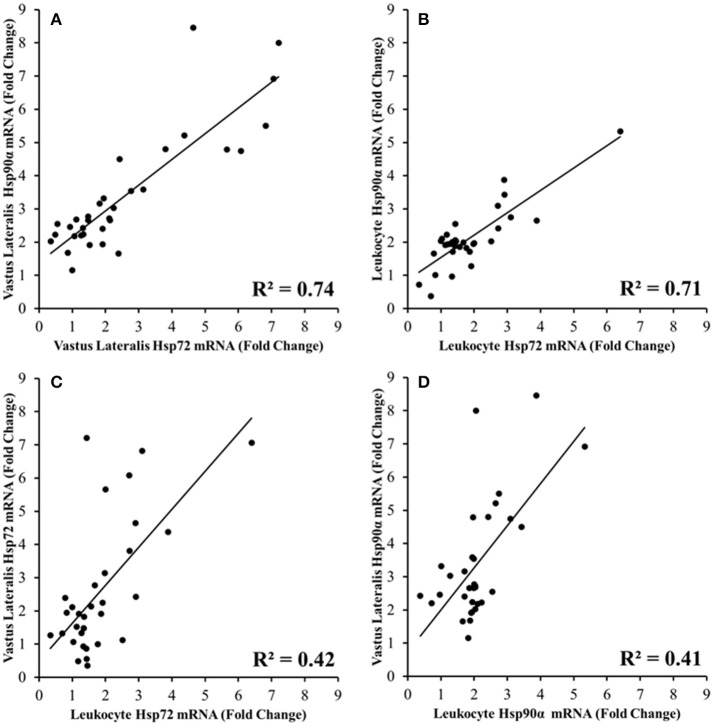
Relationships between Hsp72 (A,C) and Hsp90α mRNA (B,D) responses in the Vastus Lateralis and Leukocytes immediately before, immediately post, 3 h post TPC1TEMPFLAT and HPC1HOTDOWN (all p < 0.001).